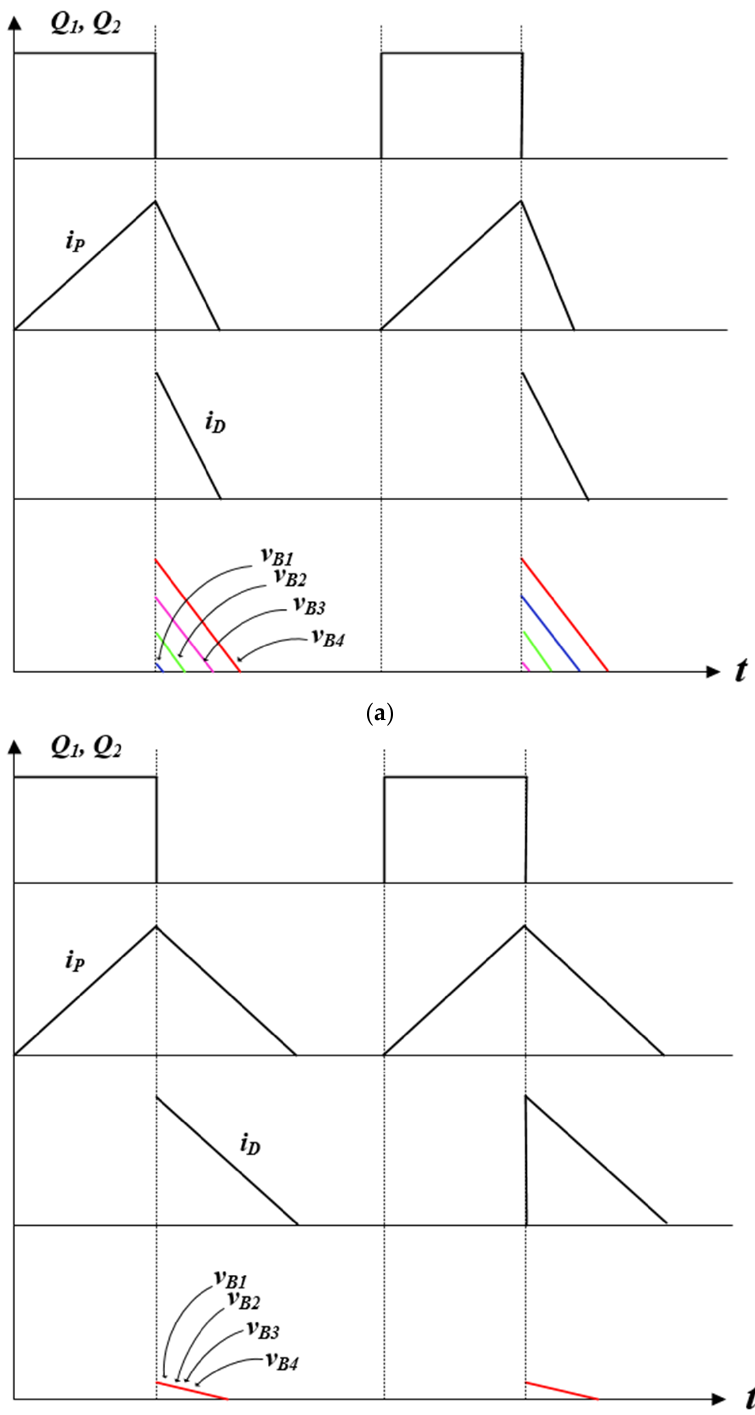
Figure 7. Operation graph of voltage balancing ( a ) before balancing control and ( b ) after balanc- ing control.